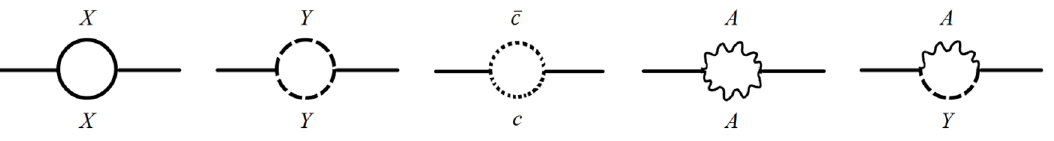
Figure 4 . The loop diagrams contributing to the finite part of Z (¯ φ, ξ ) in Cartesian coordinates, which is dominated by the gauge-boson-Goldstone loop in the parameter regime we are interested